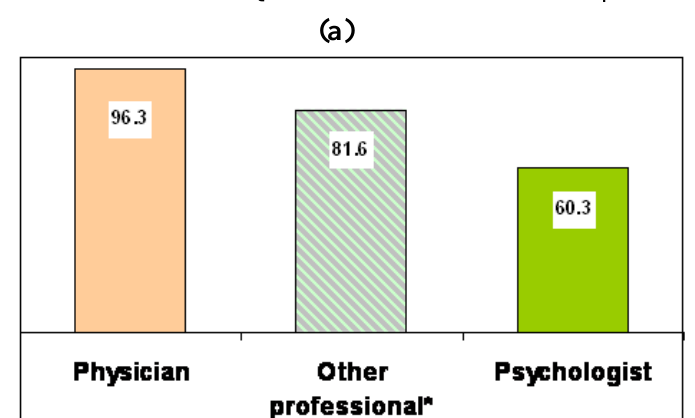
Figure 3. Professionals’ Qualification and Team